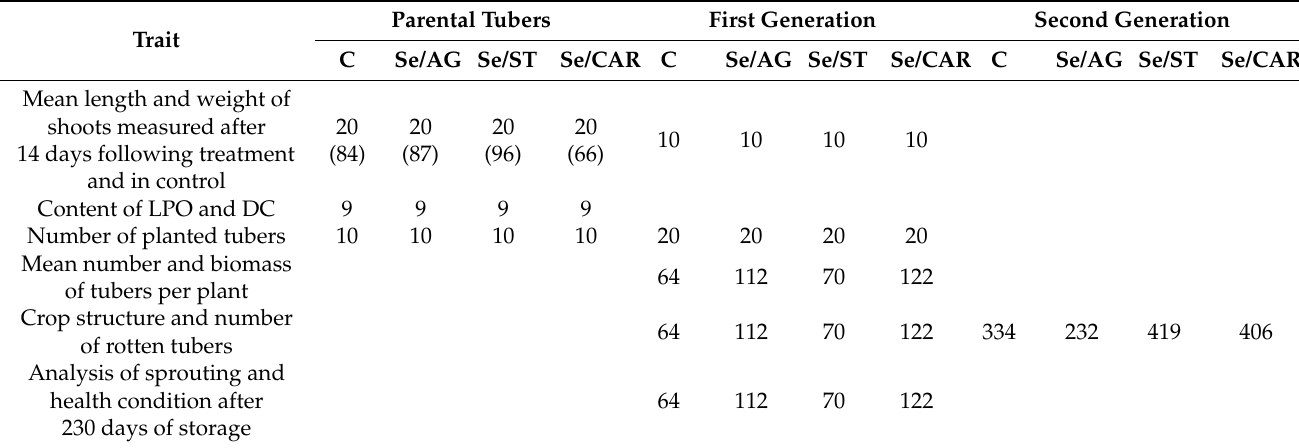
Table 1. Numbers of tubers and shoots (in brackets) studied for each trait in the parental tubers, and in the first and second generations obtained from tubers treated with selenium (Se) nanocomposites (Se/AG, Se/ST and Se/CAR NCs) and in the control